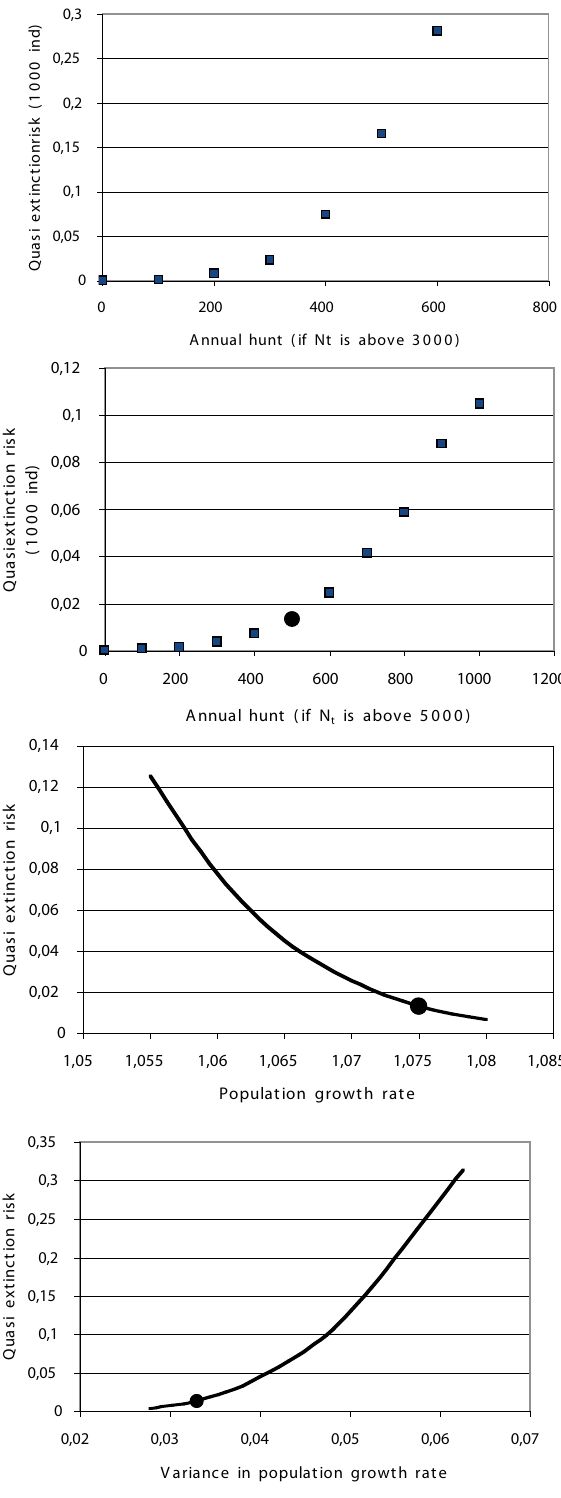
Grey seals in the North Atlantic and the Baltic